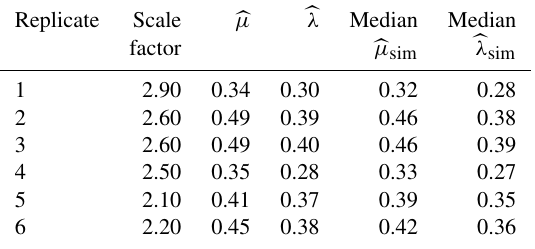
Table 2. Estimates of stochastic spread model parameters, µ and λ , based on data from each of six microfires. The grid cell sizes used in the spread model were taken as the camera pixel size divided by the given scale factor. The two rightmost columns of the table give the medians of the estimates of µ and λ for 100 simulated data sets generated according to the fitted stochastic spread model using the observed-data estimates of µ and λ